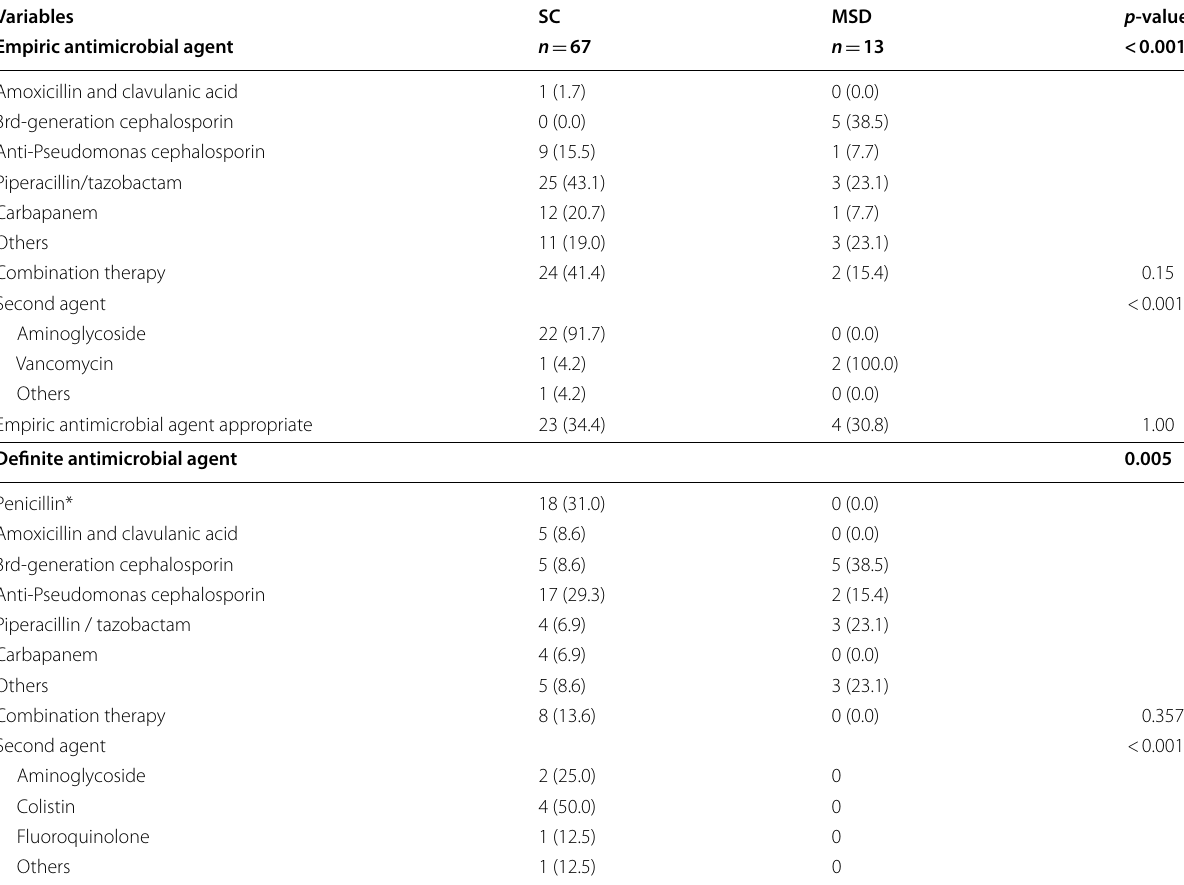
Table 3 Antimicrobial agents administrated for first acquired infection in both